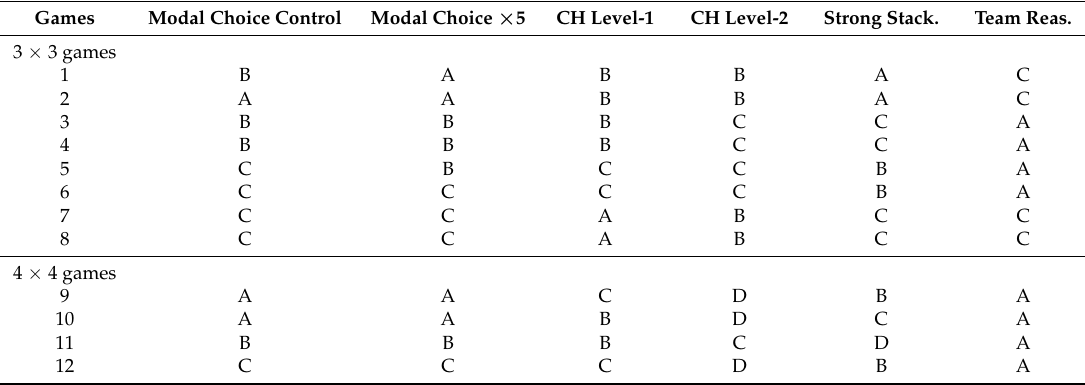
Table 2. Modal choices of players in 12 original games and 12 × 5 versions of the same games, and unique strategy choice predictions for Player 1 of cognitive hierarchy (CH) theory for Level-1 and Level-2 reasoning, strong Stackelberg reasoning, and team reasoning.